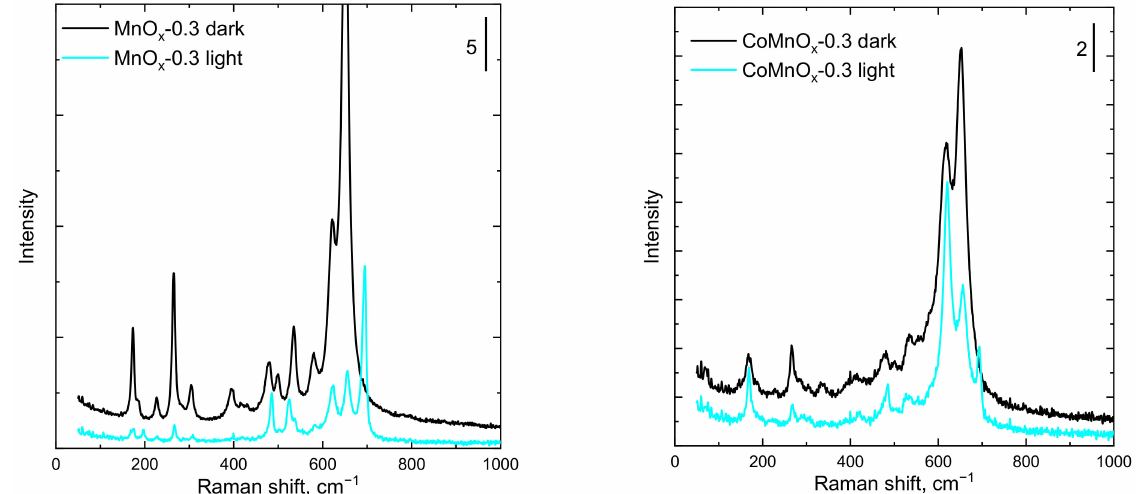
Figure 6. Raman spectra of MnOx–0.3 ( left ) and CoMnOx–0.3 ( right ) catalysts determined in two different points, light and